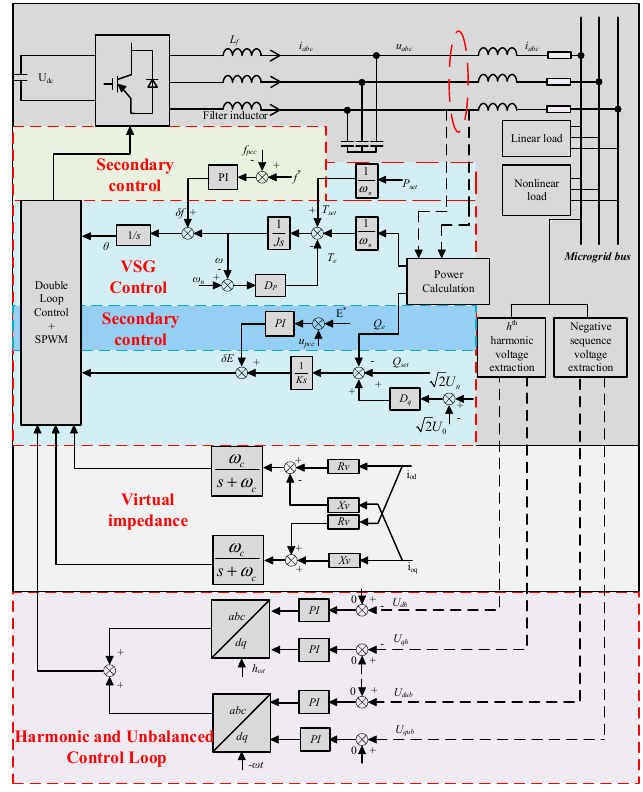
Figure 3. The block diagram of main control strategy.